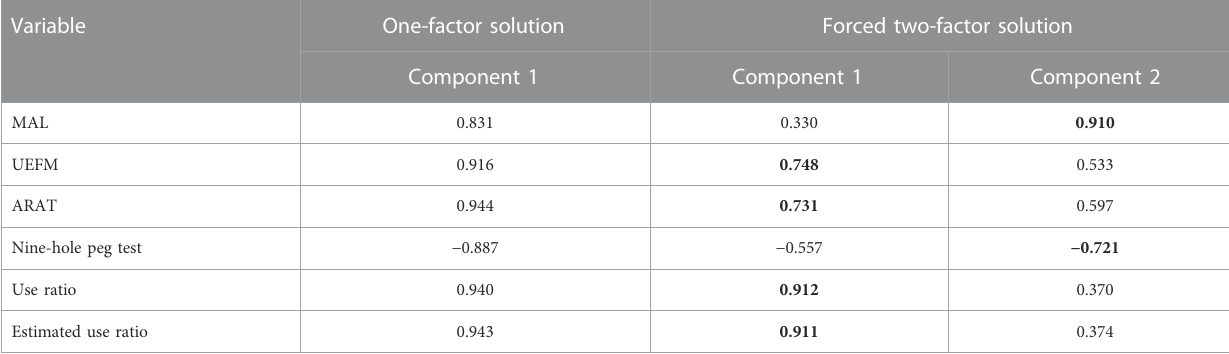
TABLE 3 Principal component loadings for 1- and 2-factor solutions.